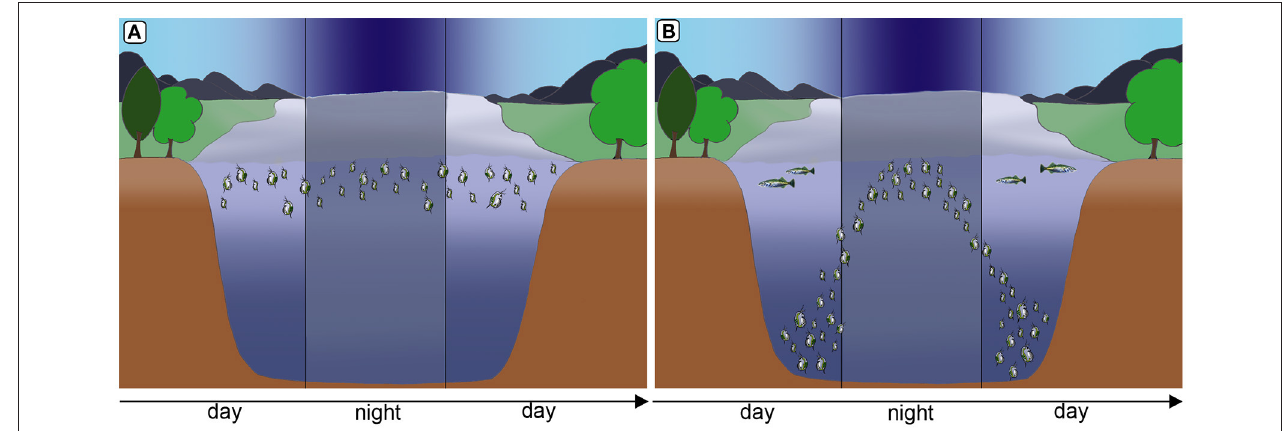
FIGURE 1 | Diel vertical migration as a form of behavioral defense in Daphnia to counter fish predation. In the absence of fish predation Daphnia remain in warm, nutritious water strata (A) . Under predation, Daphnia migrate to deeper water strata, seeking refuge from visual predators. However, during the night they migrate to nutrient rich and warmer strata for feeding (B) . Images by Weiss.